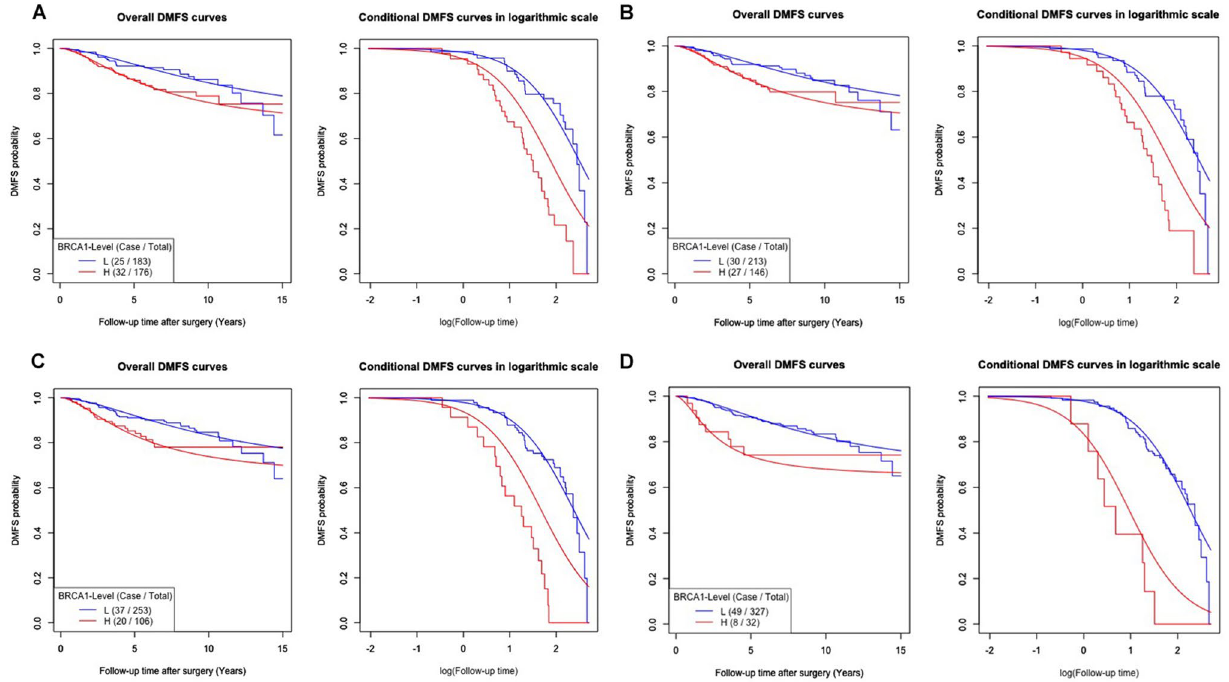
Figure 2. Survival curves fitted by the “Logistic-AFT mixture regression model” at the 5th–7th and 9th deciles. Kaplan–Meier (step function) and mixture regression (smooth curve) estimators of overall and conditional DMFS curves for the DM onset time after surgery stratified by BRCA1 level defined at the cutoff points ( A ) 5th, ( B ) 6th, ( C ) 7th, and ( D ) 9th deciles, and the corresponding p values of the likelihood ratio test (P LRT ) were 0.024, 0.023, 0.020 and 0.005, respectively. The BRCA1 high- and low-expression groups are shown in red and in blue, respectively, for each cutoff point.